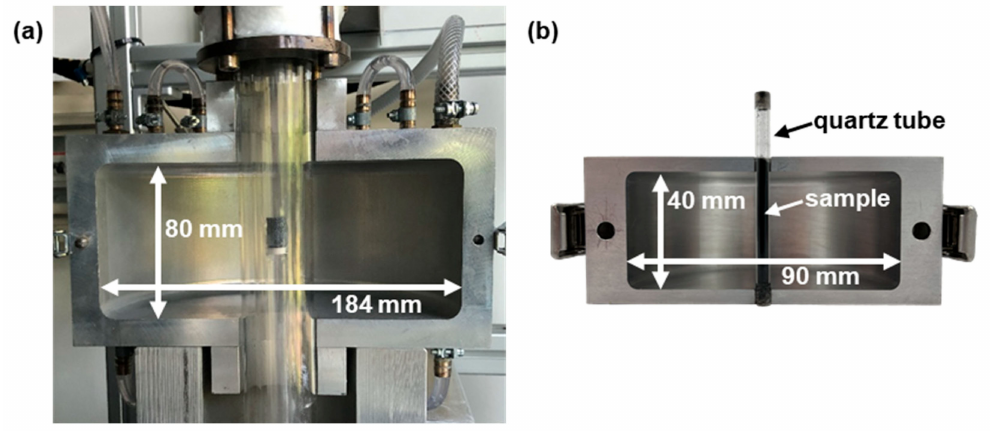
Figure 1. Images of the resonators used in this work. ( a ) Resonator with possibility to heat the sample; described in more detail in [28]. ( b ) Non-heatable resonator with smaller cavity compared to ( a